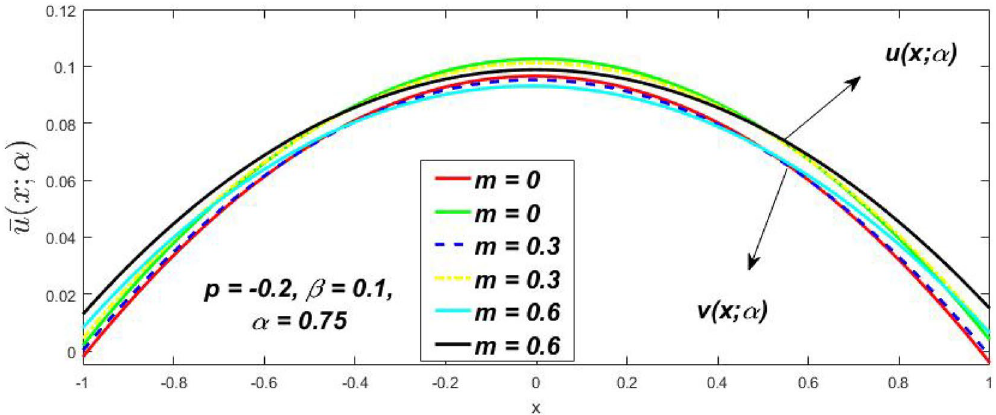
Figure 22. Fuzzy velocity profiles for the impact of m.